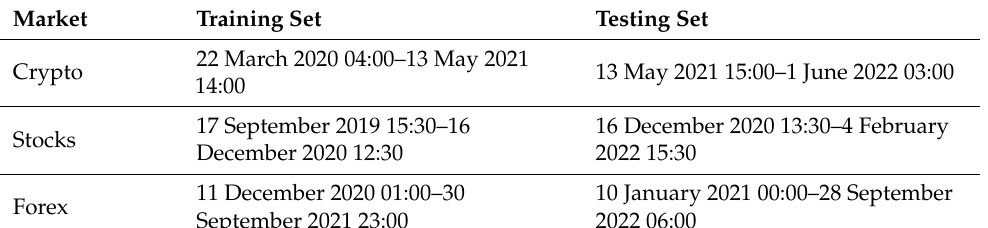
Table 2. Training and testing splits.